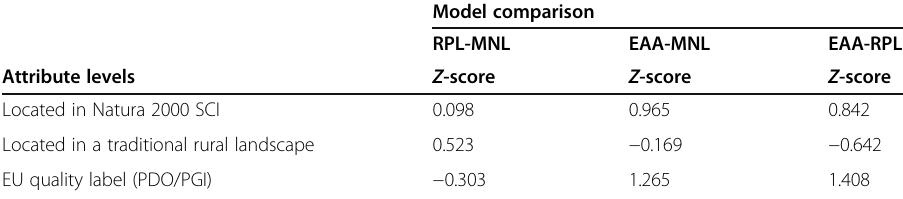
Table 6 Z -test (two-tailed) of equality of the estimated mean WTPs between models Model